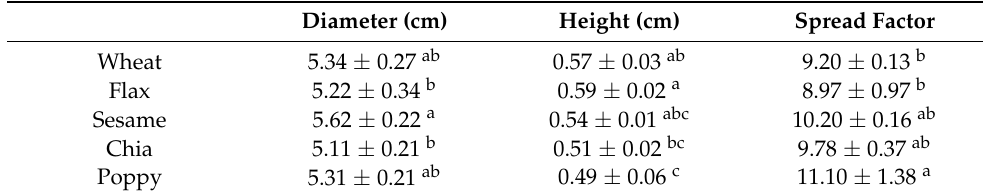
Table 1. Mean values for size parameters (diameter and height) and spread factor for all of the cookies.